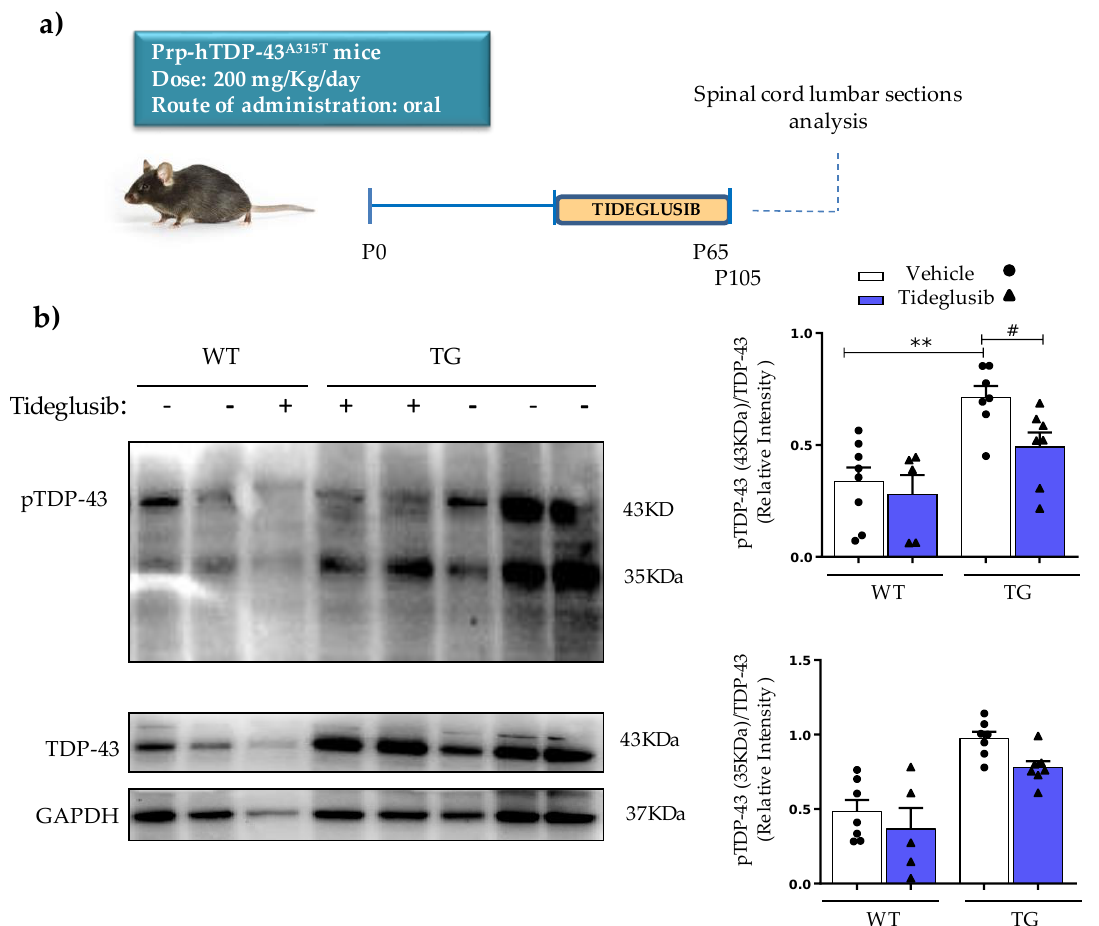
Figure 6. Effects of Tideglusib on levels and phosphorylation status of TDP-43 in the spinal cord of wild-type and transgenic TDP-43 (A315T) mice. ( a ) Experimental design of oral administration of the Tideglusib to wild-type and TDP-43 transgenic mice. ( b ) Effects of Tideglusib treatment on levels and phosphorylation status of TDP-43. Spinal cord lysates from wild-type (WT) and transgenic TDP-43 (TG) mice were used to determine the levels of pTDP-43 and TDP-43. Representative immunoblots are shown. Densitometric analyses represent the ratio of pTDP-43/TDP-43. Values are expressed as mean ± SEM; N ≥ 6 animals in each group (** p < 0.01 vs. WT-Veh group; # p < 0.05 vs. TG-Veh group).